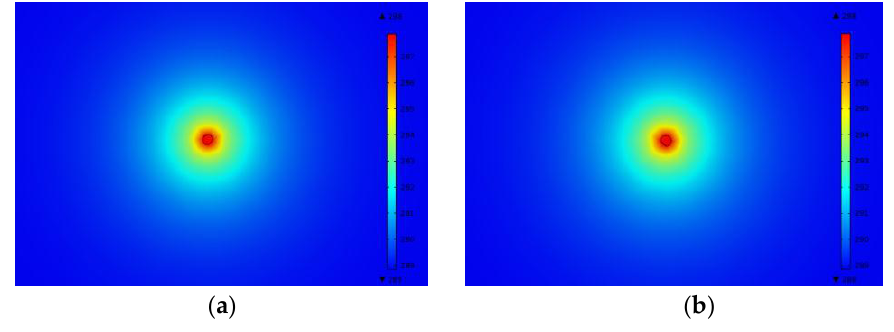
Figure 2. Temperature response after one-month (u = 0 m/s, D/L ratio = 0.00075). ( a ) Borehole permeability same as ground; ( b ) Impermeable borehole.